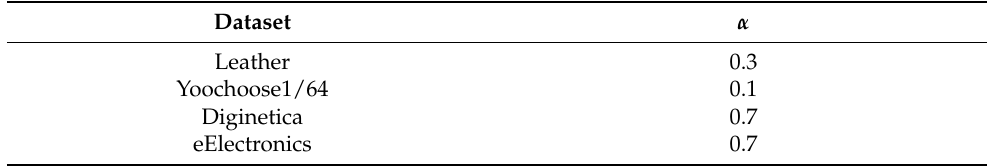
Table 3. Optimal values of the α parameter in the RIC